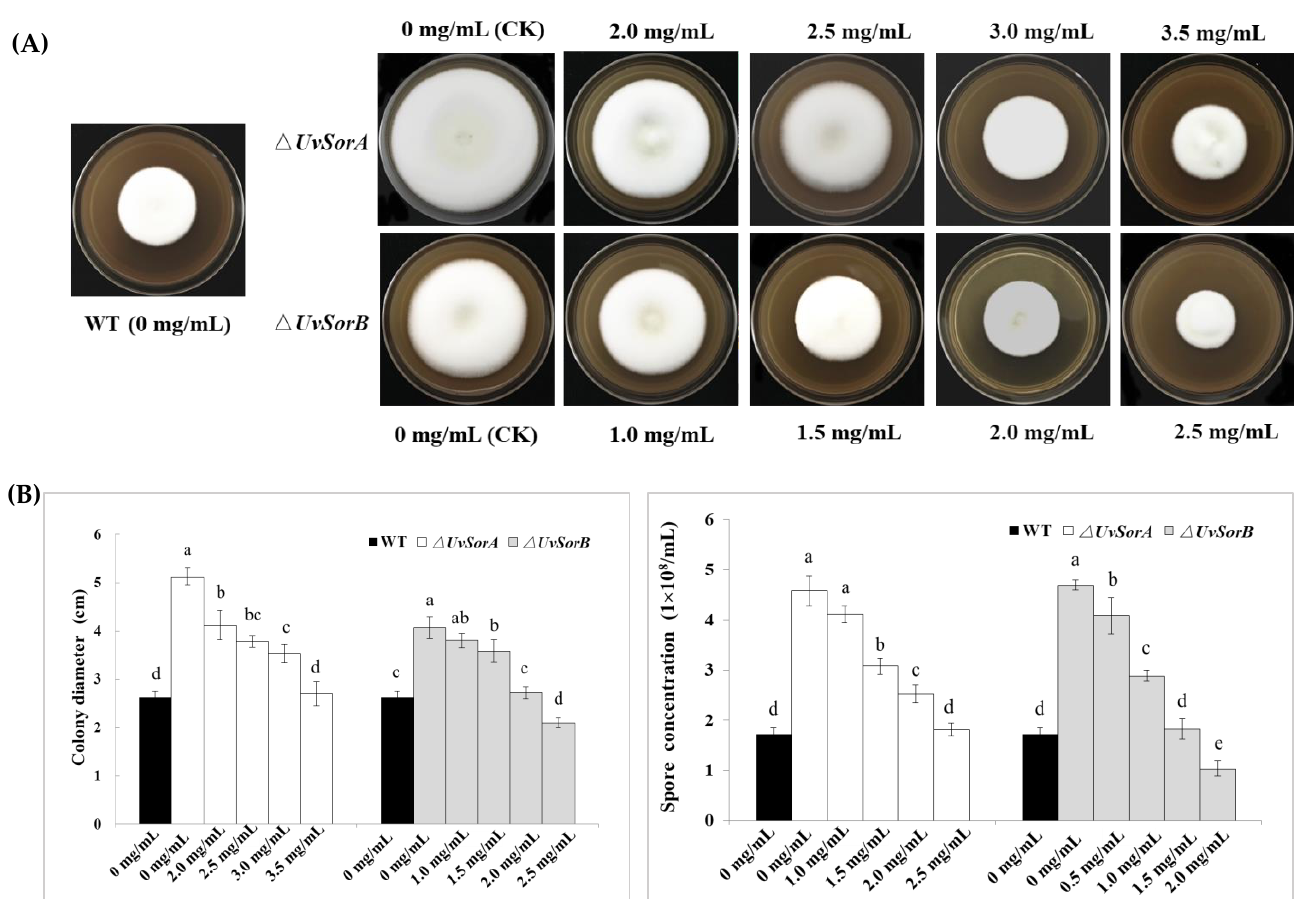
Figure 7. Sorbicillinoids feeding experiment in ∆ UvSorA and ∆ UvSorB mutants . ( A ) Colony morphology of Δ UvSorA and Δ UvSorB mutants were incubated on GYES at 28 °C for 21 days , supplemented with different concentrations of sorbicillinoids; ( B ) Statistical analysis of colony diameters (left panel) and spore concentrations (right panel) in feeding experiment. ΔUvSorA and ΔUvSorB mutants and WT were incubated on PSB at 28 °C with 160 rpm for 7 days supplemented with different concentrations of sorbicillinoids. Three independent biological experiments were performed with three replicates each time. Error bars represent the standard deviation. Different letters (a – e) indicate significant differences among the data of each treatment at p < 0.05.